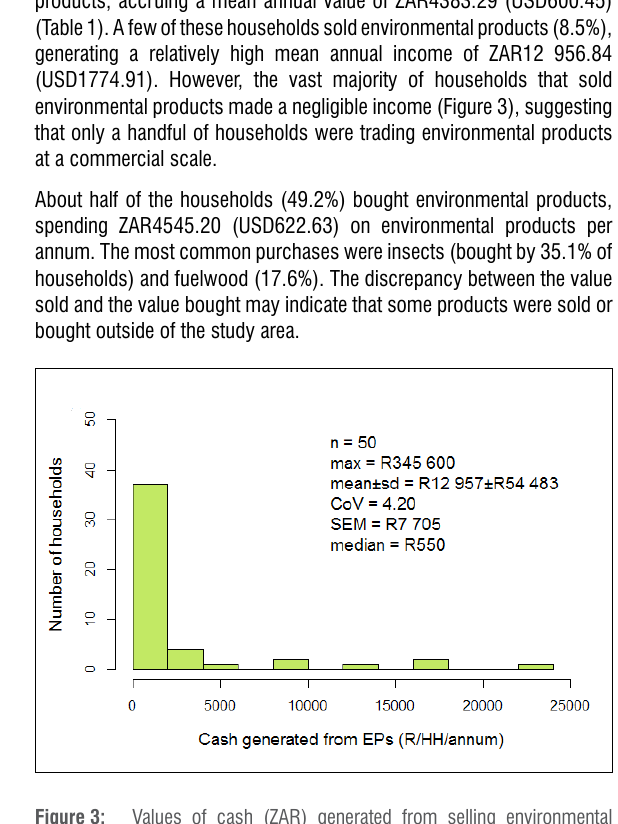
Values of cash (ZAR) generated from selling environmental products (EPs) per household (HH) per annum across a sample size of 590 households in 2010, in Bushbuckridge,